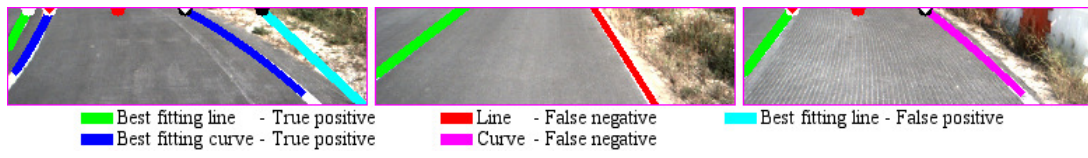
Figure 8. False positive and negative results. The left image shows a false positive case where the rightmost lane marking in cyan was detected due to the fact that the midpoints from the sand region were extracted as candidates in Section 3.1 steps three and four (see Figures 5 and 9 rows 3, 4 and 5). The last two images show the case of a false negative; in this case, tracking using the previous line/curve fit model is implemented. The line in red shows the results of the tracking, while the magenta shows the results for the curve fitting. In the middle image, the false negative result was due to the fact that the lane marking edges were outside the range during the midpoint extraction process. This happened because there was spilled paint along the lane marking. In the case of the right image, the algorithm was not able to detect the lane marking because of the deterioration of the